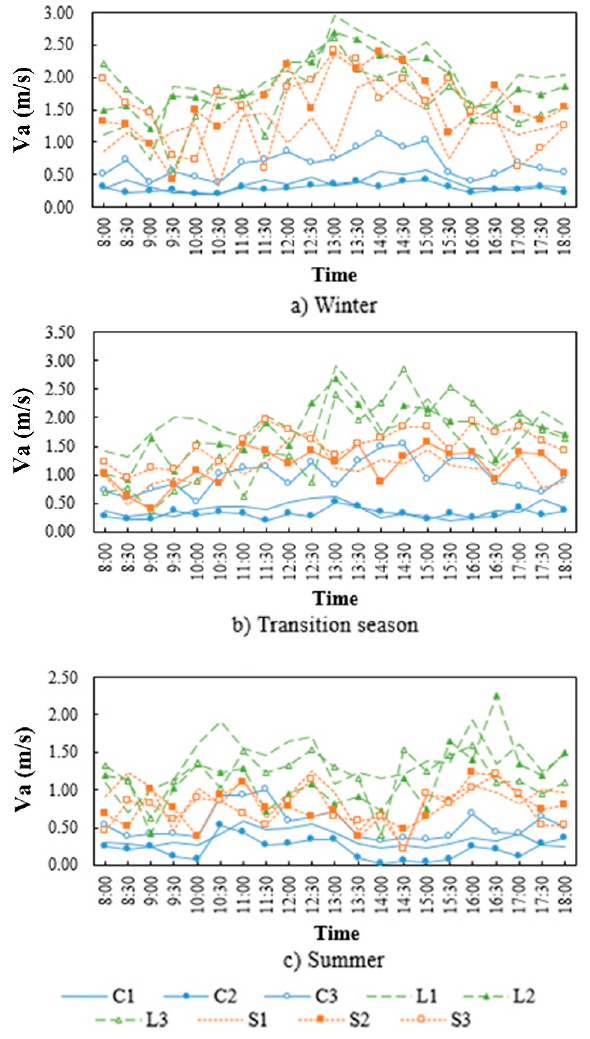
Figure 6. Temporal variation of wind speed for each measurement point in different seasons.